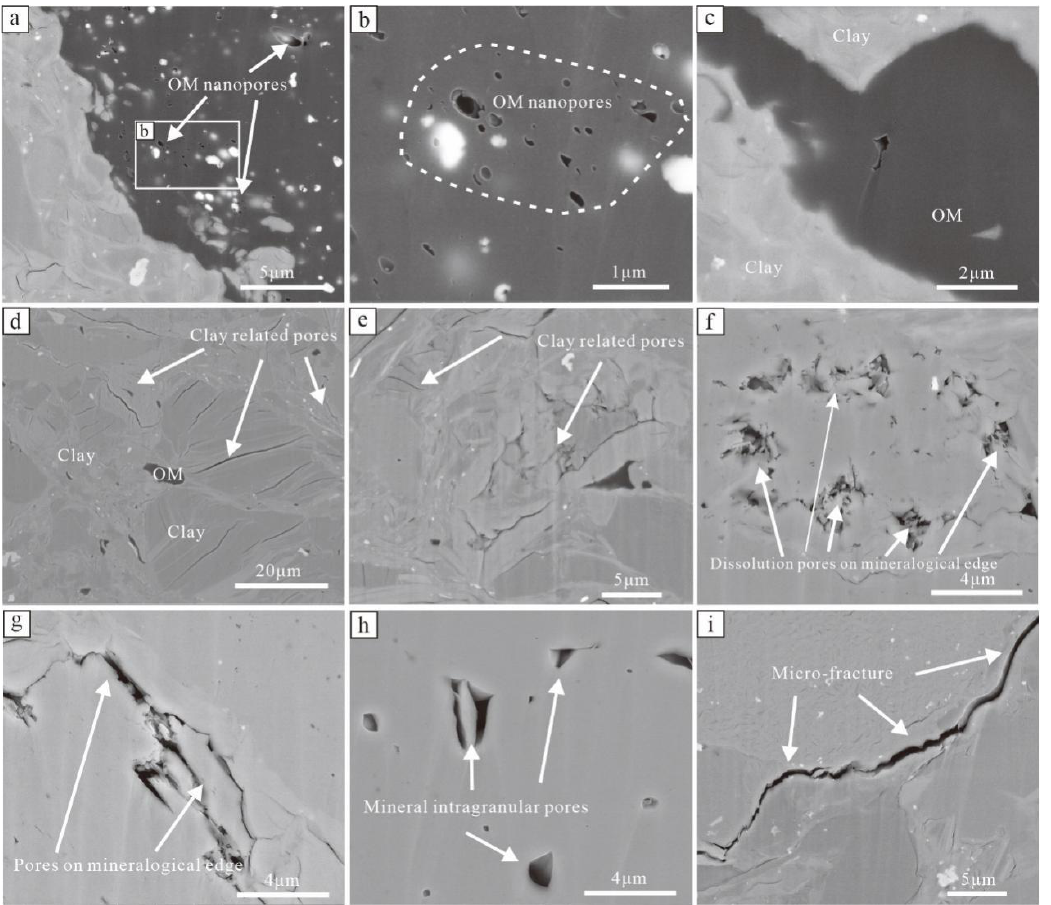
Figure 5. Microreservoir space of nano–micro pores and small-scale fractures in transitional shale gas reservoirs. ( a ) Pores and pyrite developed within organic matter; ( b ) Gas pores in OM; ( c ) OM with pores not developed; ( d ) intergranular pores between lamellar clay crystals; ( e ) pores between clay mineral aggregates; ( f – h ) pores on mineralogical edge; ( i ) microfractures on the mechanical weak surface.